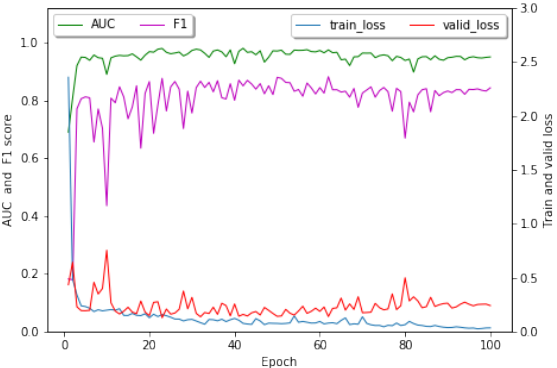
Figure 9. Convergence analysis of SSAE.